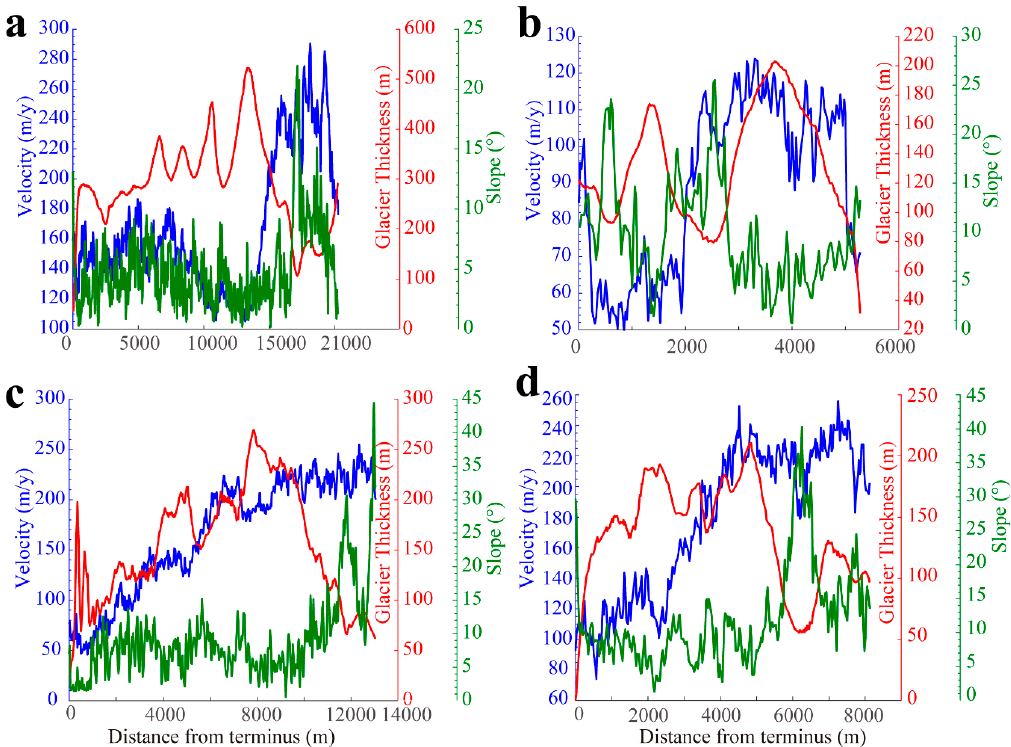
Figure 11. Annual mean centerline glacier velocity (blue line) versus glacier thickness (red line) versus slope (green line): ( a ) Yanong Glacier (GLIMS ID G096657E29334N); ( b ) Parlung No.4 Glacier (GLIMS ID G096920E29228N); ( c ) Azha (GLIMS ID G096818E29132N); and ( d ) Xueyougu Glacier (GLIMS ID G096758E29147N).